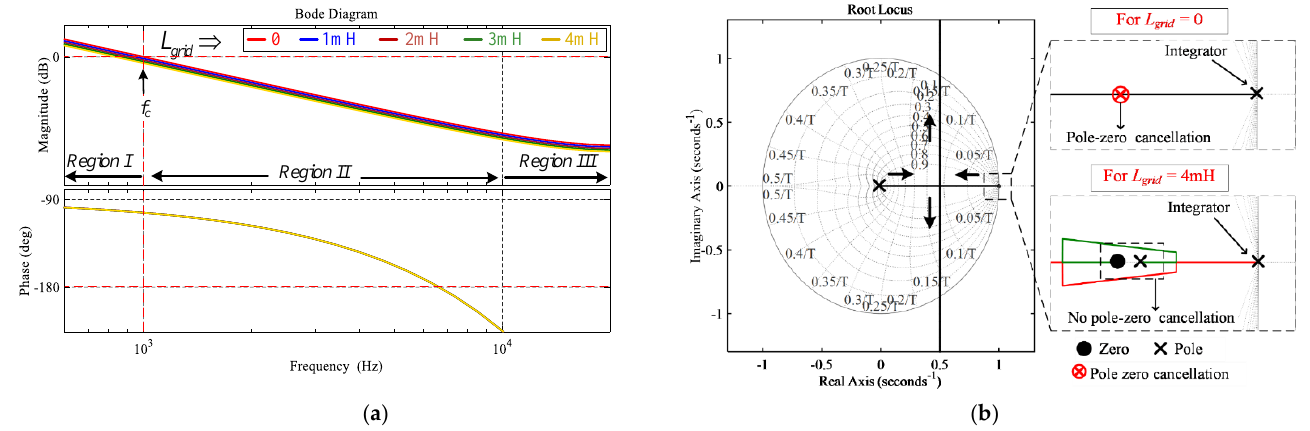
Figure 5. Frequency response of Loop gain for L filter type GcI with single-loop PI control under L grid variation ( a ) Using Bode Plots; ( b ) Root Loci.